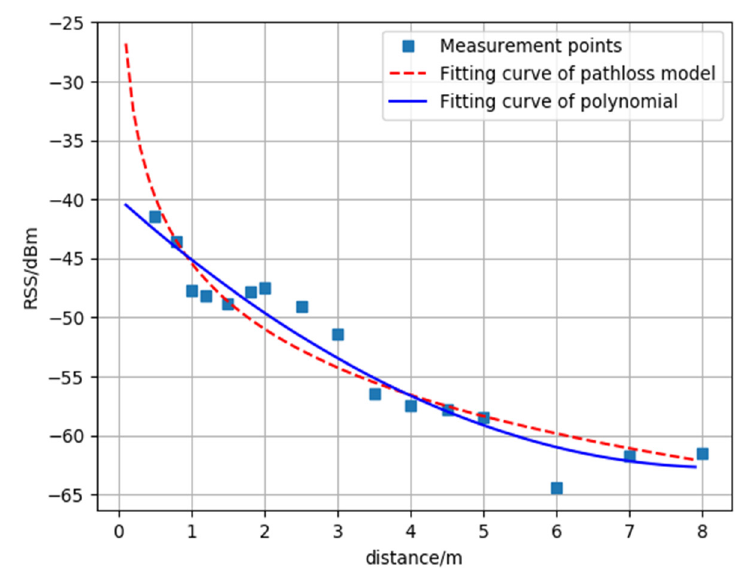
Figure 3. Relationship between RSS and the distance of the experiment data. The solid “ □ ” represents the average RSS at each test distance, the red dotted line shows the path-loss curve, and the blue solid line represents the fitting curve of the quadratic polynomial.